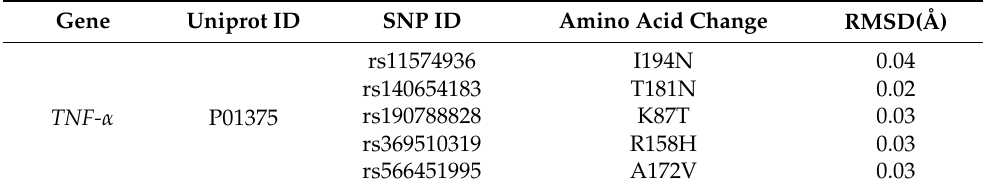
Figure 3. PyMOL was used to visualize 3D structure comparison modeling of the CYP3A5 protein. ( a ) A sphere-shaped native amino acid phenylalanine (yellow) with a mutant amino acid serine (purple) at position 446. ( b ) The native amino acid arginine (yellow) with the mutant amino acid lysine (purple) at position 439. ( c ) A sphere-shaped native amino acid tyrosine (yellow) with a mutant amino acid cysteine (purple) at position 53. ( d ) The native amino acid proline (yellow) with the mutant amino acid serine (purple) at position 416. Table 2. RMSD value of TNF- α protein.